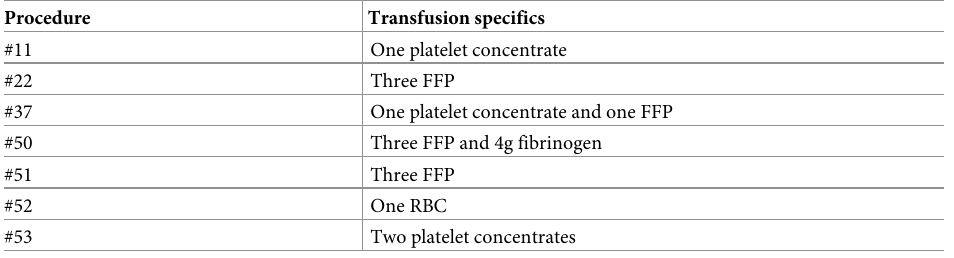
Table 4. Postoperative transfusion requirements until intensive care unit